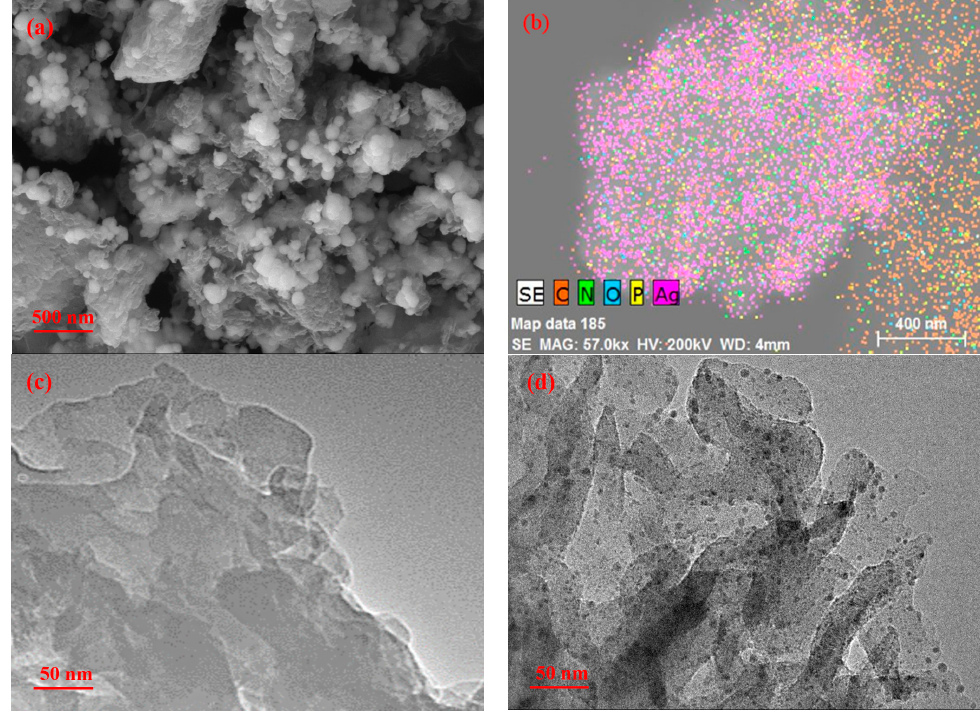
Figure 3. ( a ) SEM image of Ag 3 PO 4 /g ‐ C 3 N 4 (30%); ( b ) Element mapping of the Ag 3 PO 4 /g ‐ C 3 N 4 (30%); ( c ) TEM image of g ‐ C 3 N 4 ; and ( d ) TEM of Ag 3 PO 4 /g ‐ C 3 N 4 (30%).